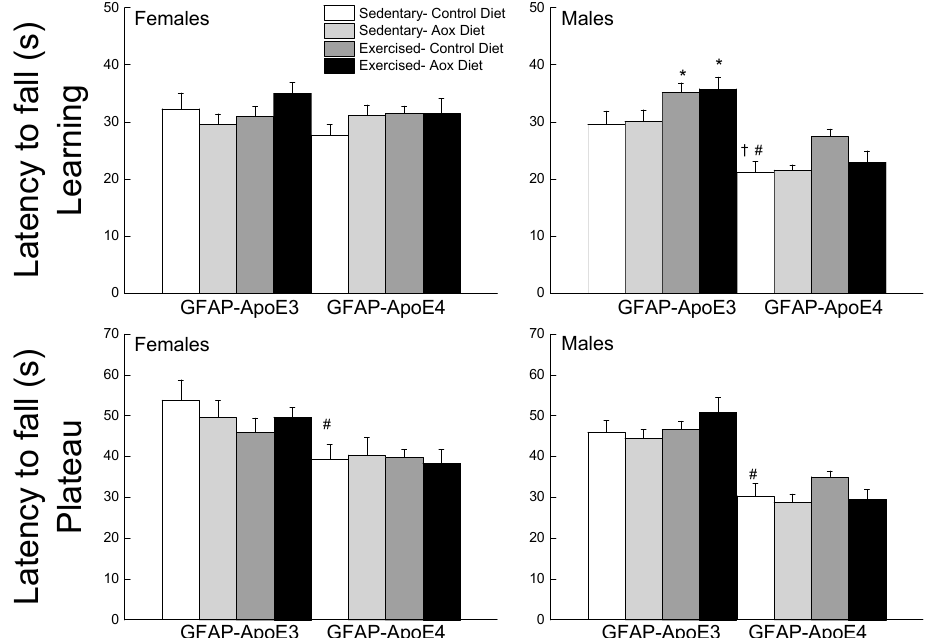
Figure 2. Exercise improved learning performance in male GFAP-ApoE3 and GFAP-ApoE4 mice, but not plateau performance. Each value represents mean ± SEM, n = 8–16. * p < 0.05 vs. sex- and strain-matched Sed-Con groups; # p < 0.05 comparing sex-matched Sed-Con GFAP-ApoE3 and GFAP-ApoE4 mice; † p < 0.05 comparing strain-matched Sed-Con males and females.